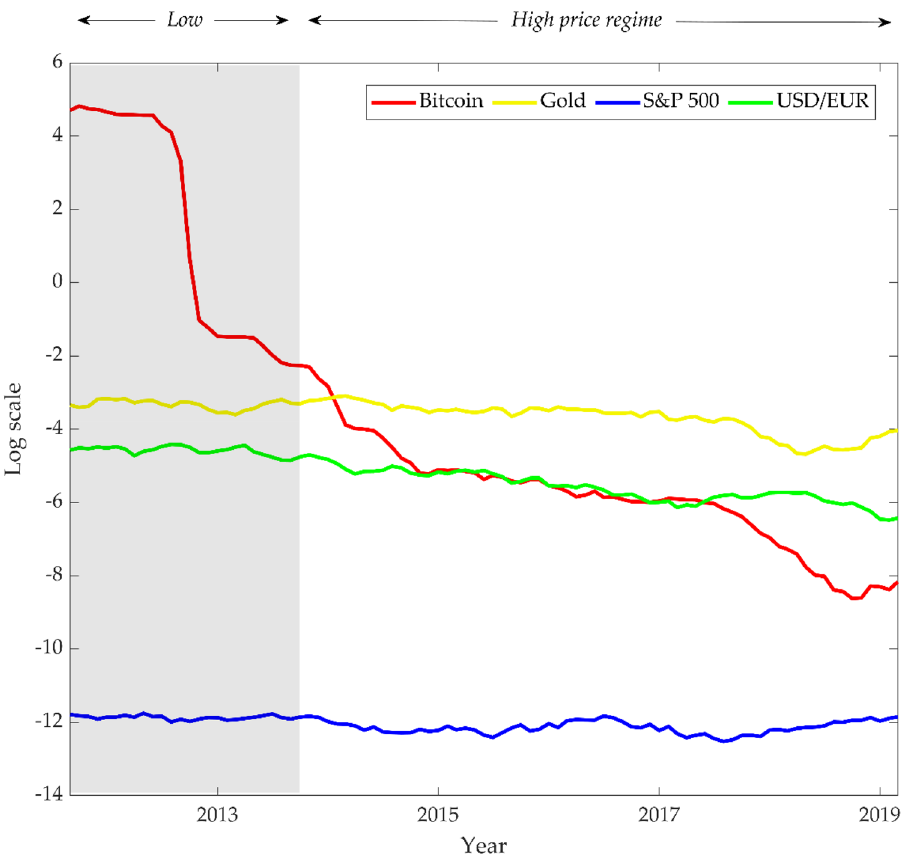
Figure 3. Amihud illiquidity of the Bitcoin, gold, S&P 500, and USD/EUR markets. Following Amihud 63 , the monthly illiquidity is estimated using the daily history of trades. The smaller the calculated illiquidity value, the greater the liquidity of the market. The red, yellow, blue, and green lines indicate Amihud illiquidity of the Bitcoin, gold, S&P 500, and USD/EUR markets, respectively. Each colored line is expressed on a log scale for comparison purposes, using data available from September 2010 to March 2019. The shaded area indicates the period of the low-price regime. The trading volume for each asset were retrieved from the following websites: https:// data. bitco inity. org/ marke ts (Bitcoin), https:// backt estma rket. com (gold), https:// finan ce. yahoo. com (S&P 500), and https:// www. fxcm. com/ marke ts